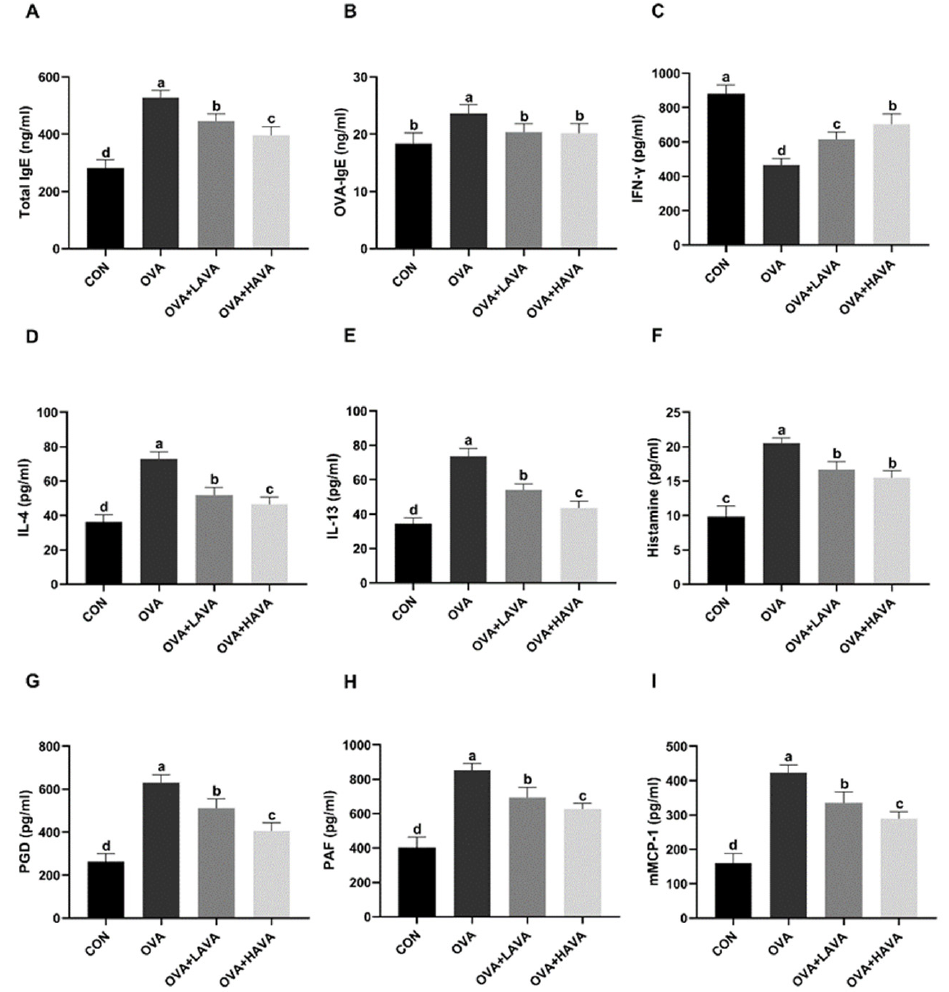
Figure 1. The antiallergic effect of avenanthramide (AVA) in ovalbumin (OVA)-induced food allergy mouse model in experiment 1. ( A , B ) Total IgE and OVA-specific IgE (OVA-IgE) in the serum, ( C – E ) interferon- γ (INF- γ ), interleukin-4 (IL-4), and IL-13 in the serum, ( F ) plasma histamine, ( G – I ) prostaglandin D (PGD), platelet activating factor (PAF) and mouse mast cell protease 1 (mMCP-1) in the serum. CON: the control group; OVA: mice orally challenged with OVA; OVA + LAVA: an OVA-challenged group that was oral gavaged with a low dose of 10 mg/kg bw AVA; OVA + HAVA: an OVA-challenged group that was oral gavaged with a high dose of 20 mg/kg bw AVA. Results are presented as means ± SDs ( n = 8). Bars with no letter in common are significantly different, p ≤ 0.05. Allergic reactions are often accompanied by inflammatory responses. Serum inflamma- tory cytokines thus were measured to investigate the inflammatory injury in OVA-induced allergic mice (Figure 2). The OVA treatment increased ( p ≤ 0.01) serum pro-inflammatory cytokines, including IL-1 β , IL-6, and TNF- α compared to the CON group. The two doses of AVA intake groups showed significant attenuation ( p ≤ 0.01) of serum IL-1 β , IL-6, and TNF- α concentrations compared to the OVA group. In contrast, the serum level of anti- inflammatory cytokine IL-10 was decreased ( p ≤ 0.01) in the OVA group compared with the CON group, but was increased ( p ≤ 0.01) in the AVA intake groups compared with the OVA group. The IL-1 β , IL-6, and TNF- α were lower ( p ≤ 0.01), but IL-10 was higher ( p ≤ 0.01) in the 20 mg/kg bw dose of AVA intake group than those in the 10 mg/kg bw dose of AVA intake